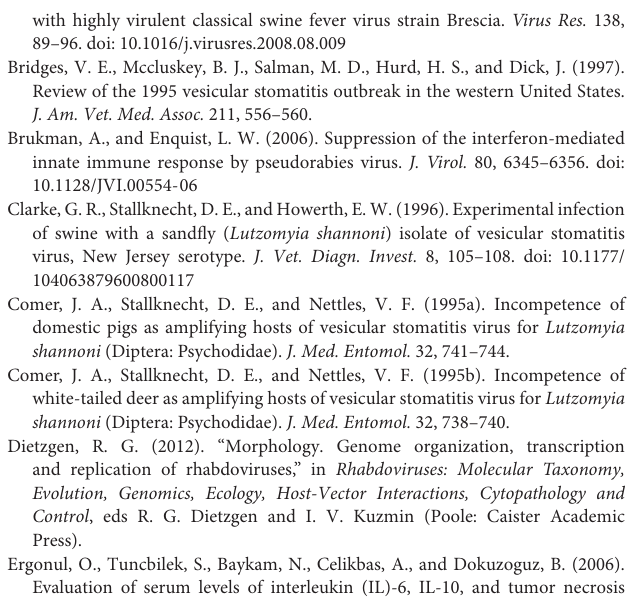
FIGURE S1 | Equal sensitivity of rRT-PCR to detect VSV viruses 1.1 and 1.2. FIGURE S2 | Synonymous substitution pattern on different genes associated with viral lineage 1.1. FIGURE S3 | Amino acid chemical